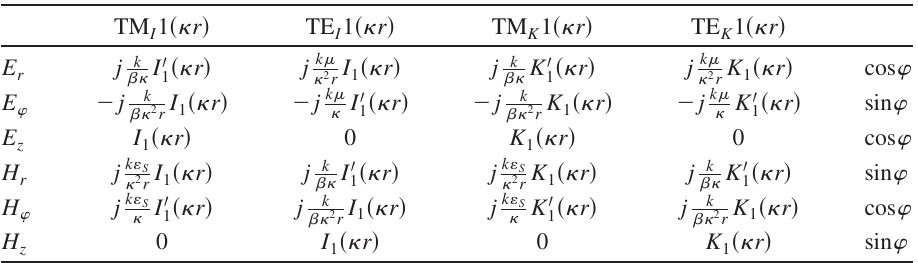
TABLE II. Dipole field